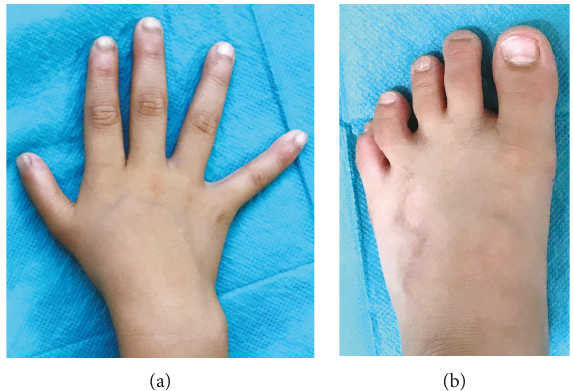
Figure 6: Two years after surgery: (a) hand and (b)